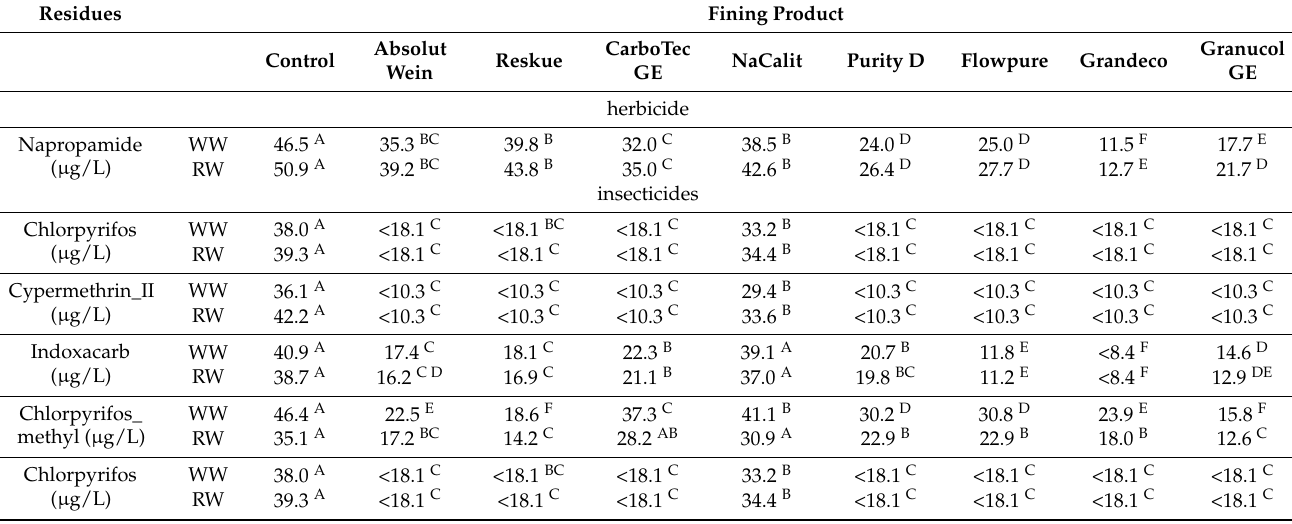
Table 7. Concentration of the herbicides and insecticides examined before and after treatment with different fining agents. Residues Fining Product